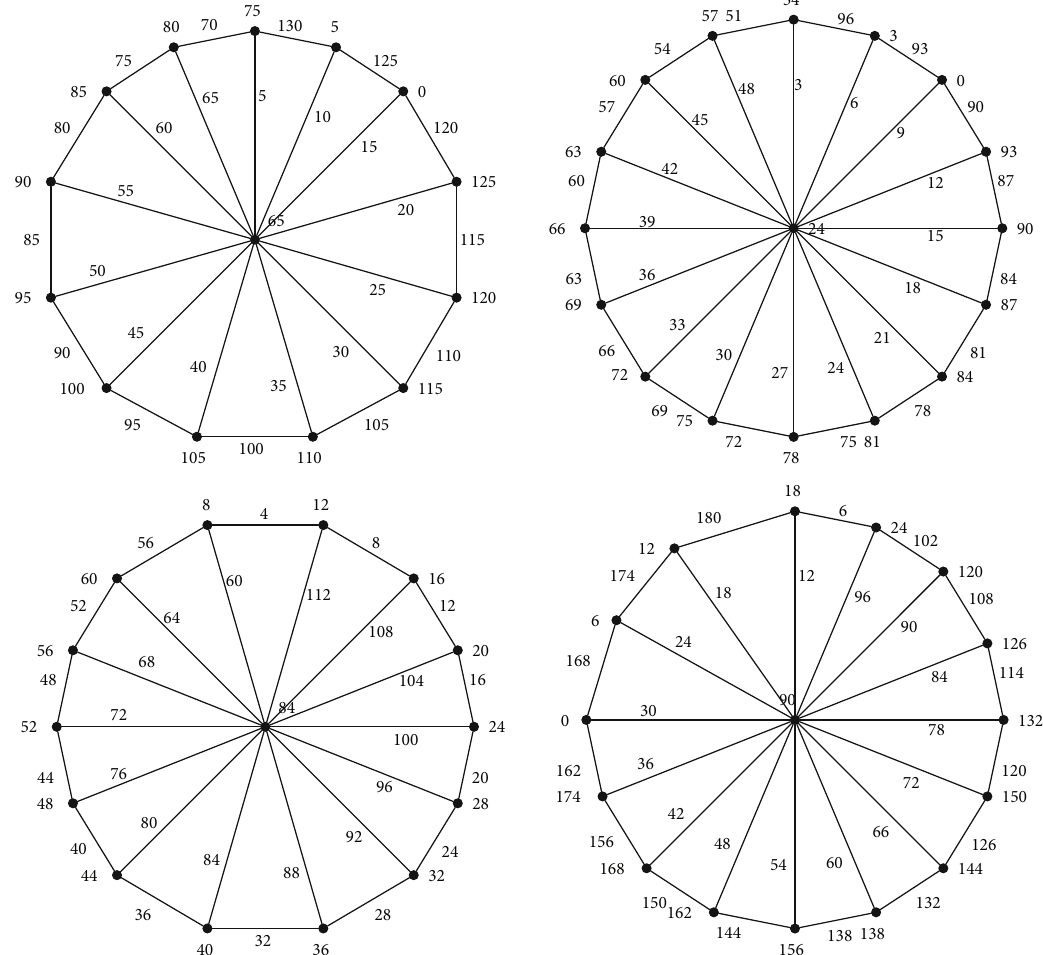
− graceful labeling, W 16 with edge 3